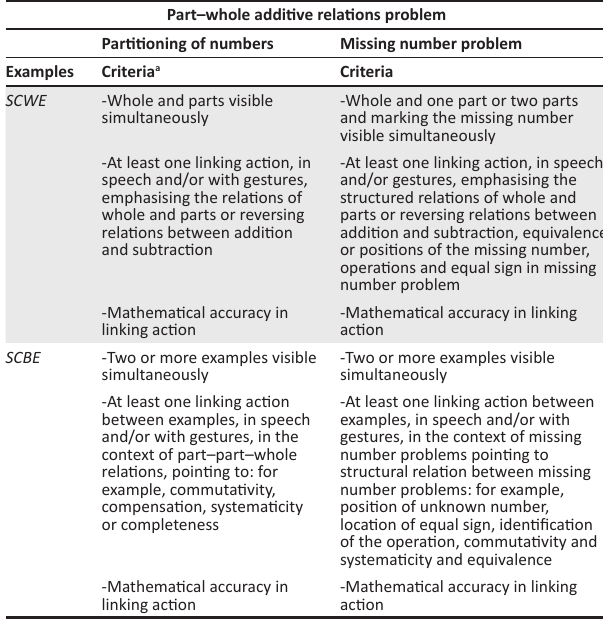
connections between examples criteria in partitioning number and missing number